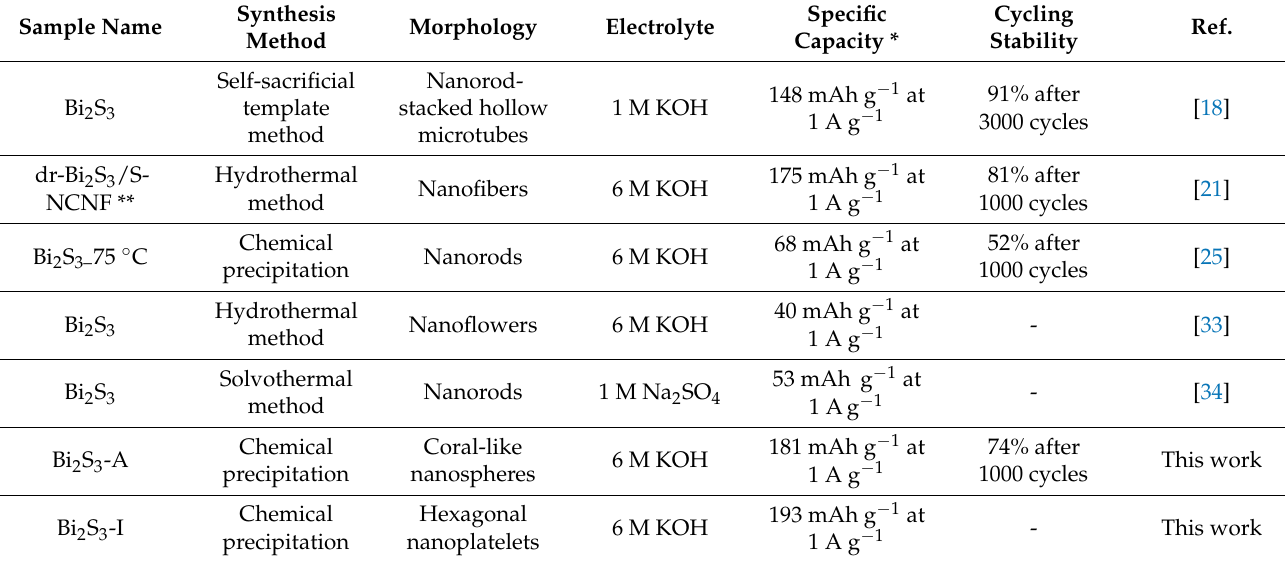
Table 2. Comparison of the electrochemical properties of the Bi 2 S 3 -based materials synthesized under different